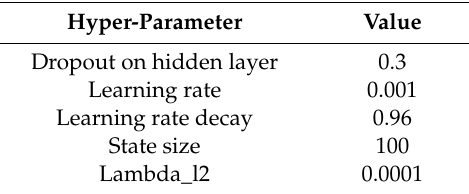
Table 3. RE models’